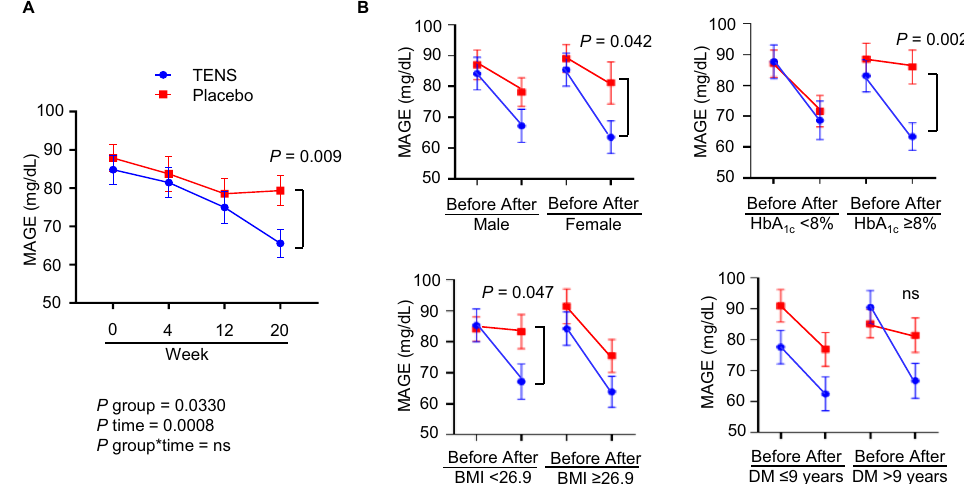
Figure 1. ( A ) Mean amplitude of glycemic excursion (MAGE) from week 0 to week 20 in the Transcutaneous Electrical Nerve Stimulator (TENS) vs. the placebo group. ( B ) Subgroup analysis of MAGE before and after treatment by gender, HbA 1c (%), BMI (kg/m 2 ) and duration of DM. Mixed model two–way ANOVA and two- sample t -test were carried out and presented with means ± standard error of mean (SEM), ns, non-significant.